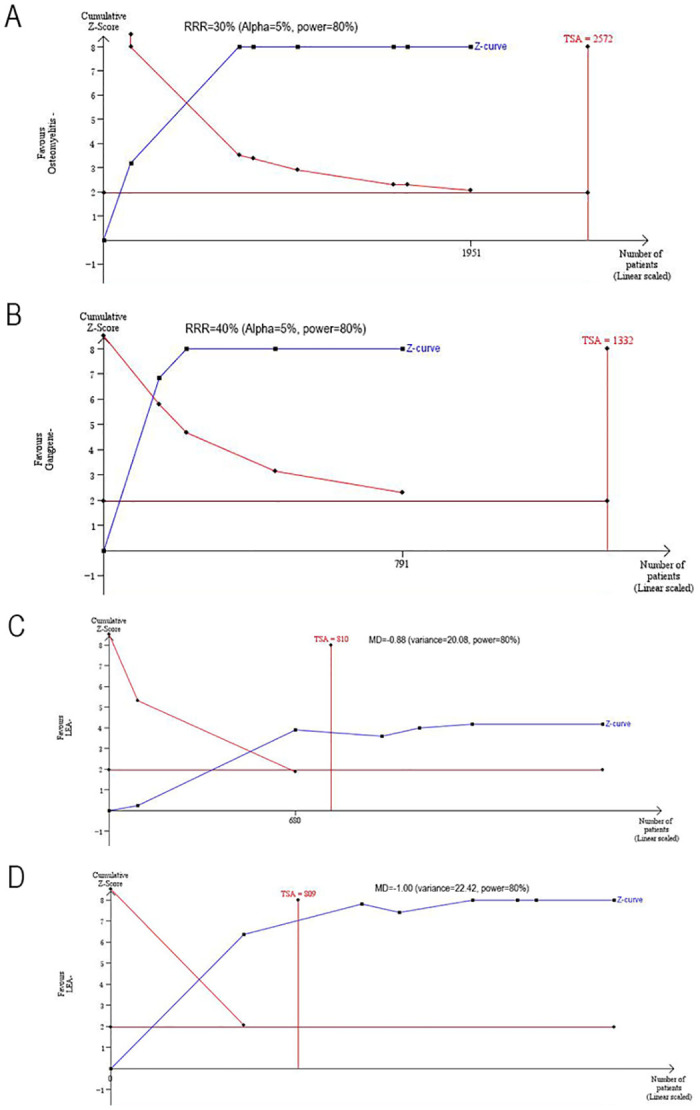
TSA results of the related risk factors.(A) Osteomyelitis; (B) Gangrene; (C) BMI; (D) WBC count. The information size was calculated based on RRR or MD, alpha of 5%, power of 80%.